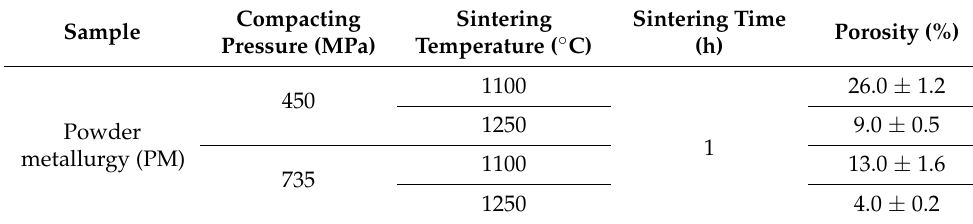
Table 3. Porosity percentage of PM samples.